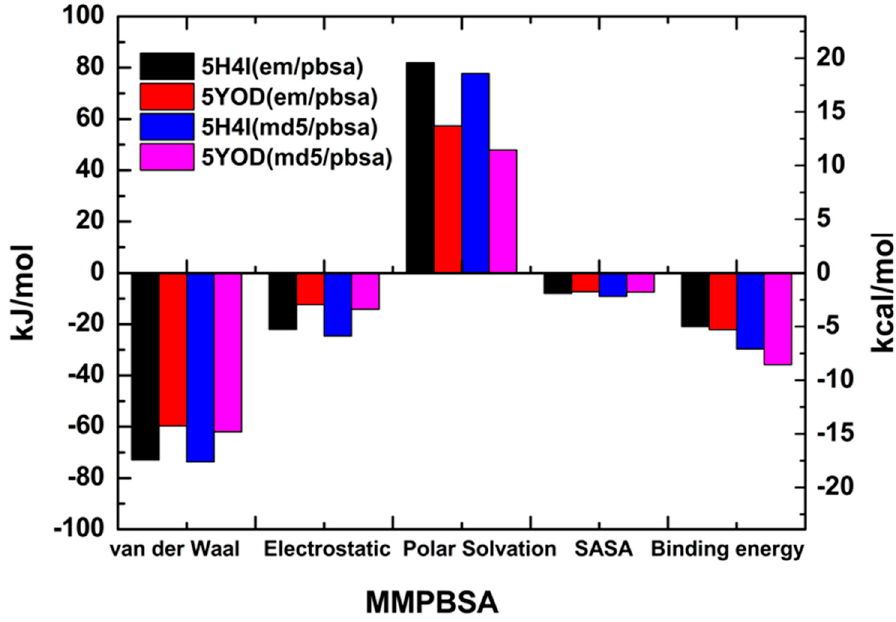
Figure 8. MM-PBSA-calculated energies for the em and md5 structures obtained from the PDB files 5H4I and 5YOD.